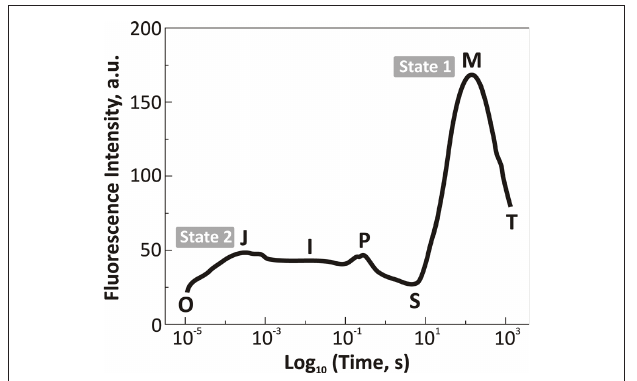
FIgurE 7 | Chl a fluorescence transient of a cell suspension of dark-adapted Synechococcus sp. PCC 7942 (Anacystis nidulans) plotted on a logarithmic time scale (from about a few μs to about 1000 s). Exciting light was 650 nm; 3000 μmol photons m -2 s -1 . The figure was modified and reproduced from Tsimilli-Michael et al. (2009). Abbreviations: O, initial (minimum) step; J and I, intermediate levels; P, peak level; S, a semi-steady state level; M, a maximum level; and T, the terminal steady state level, not quite reached in this experiment (see Govindjee and Papageorgiou, 1971). This fluorescence transient (or fluorescence induction) is quite different from that observed in green algae and higher plants, where the “OPS” transient dominates. Cyanobacteria in darkness are usually in what is called “state 2” (low fluorescence state) and it takes a long time (almost 100 s) to be transferred to “state 1” (high fluorescence state). For a recent historical review on “state changes,” see Papageorgiou and